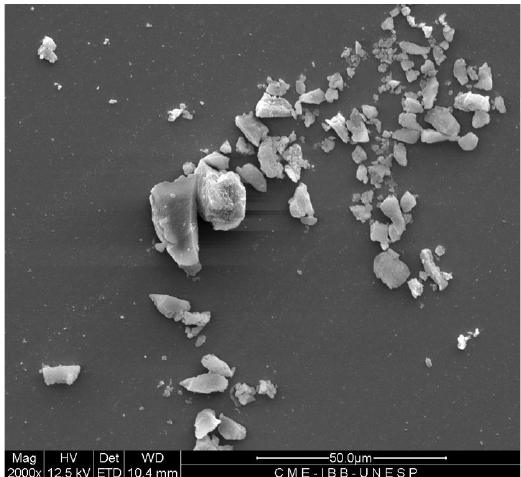
Figure 4. SEM image of the material Si ‐ Pu.